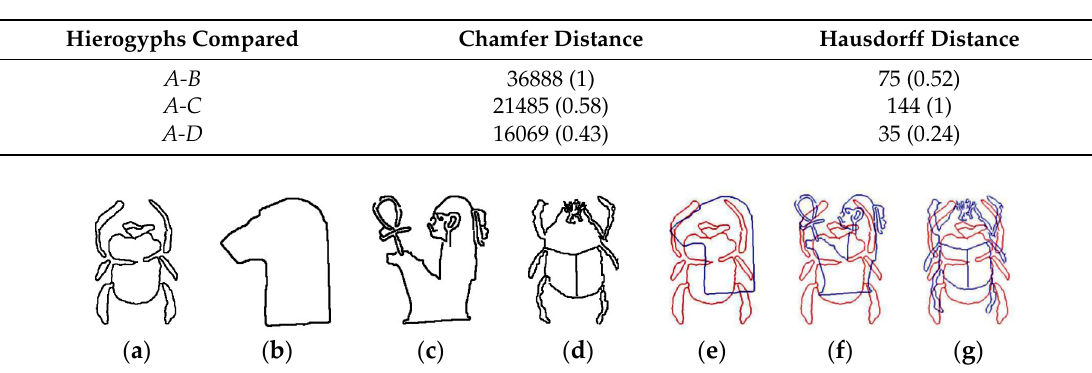
Table 1. Results of comparing Chamfer and Hausdorff distances.